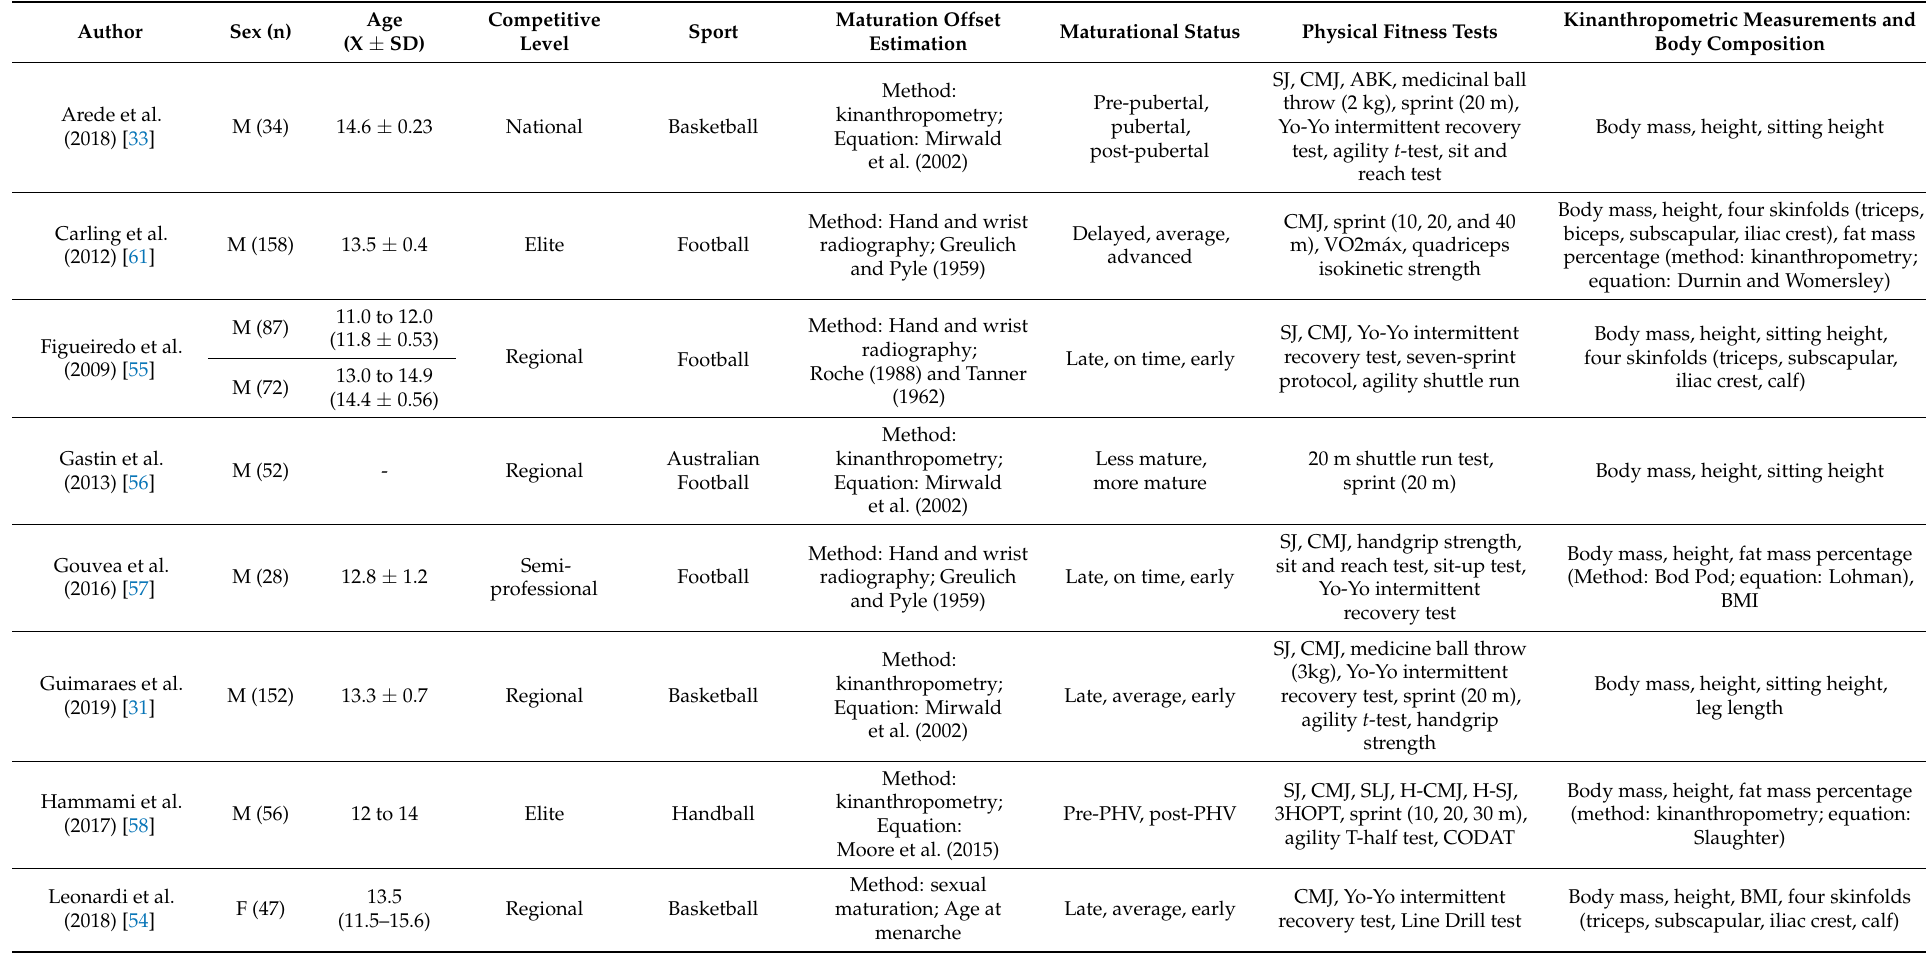
Table 1. Data extraction of the selected